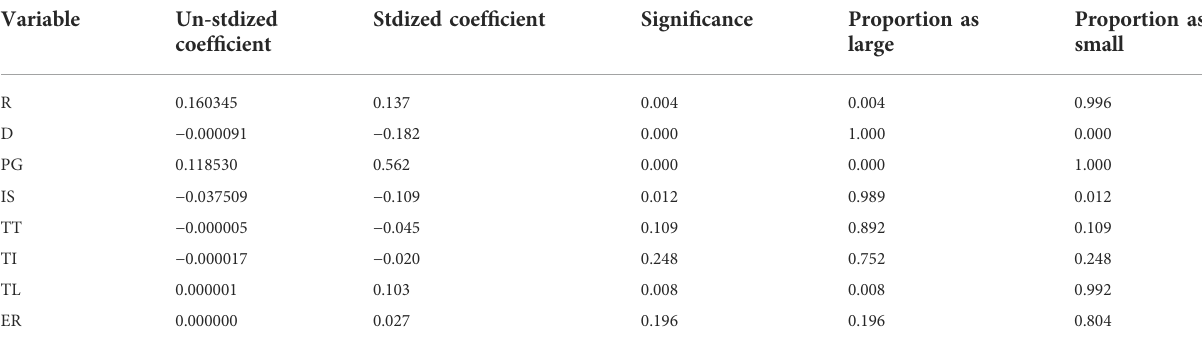
TABLE 7 The results of QAP regression